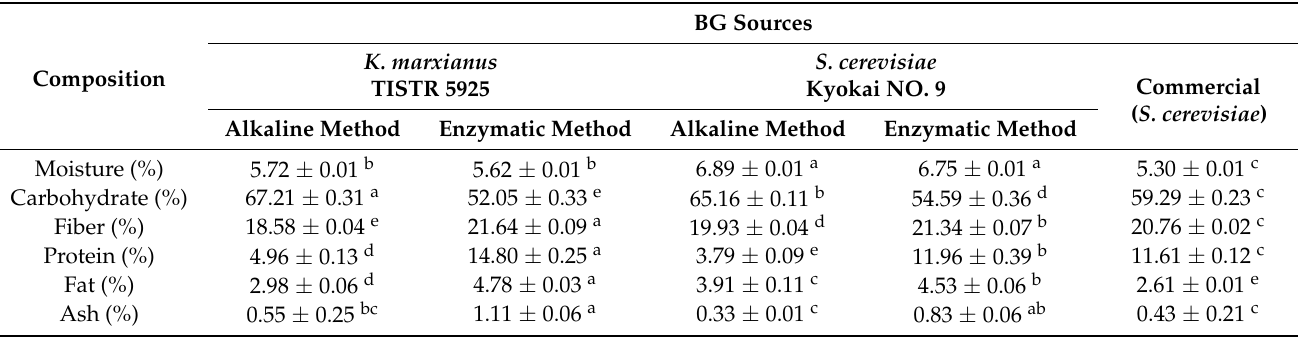
Table 2. Composition of BG extracted from K. marxianus TISTR 5925, S. cerevisiae Kyokai NO. 9, and commercially available